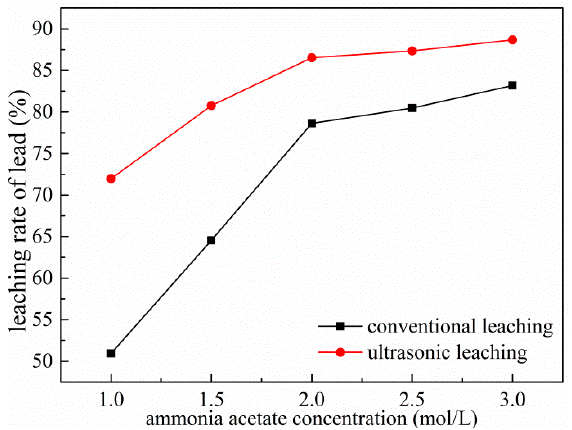
Figure 8. Effects of ammonium acetate concentration on leaching of Pb. Figure 8. E ff ects of ammonium acetate concentration on leaching of